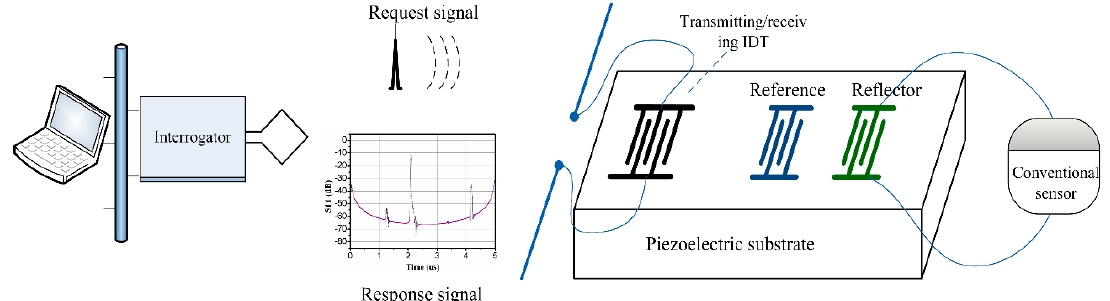
Figure 1. Schematic of an impedance-loaded surface acoustic wave (SAW) sensor.